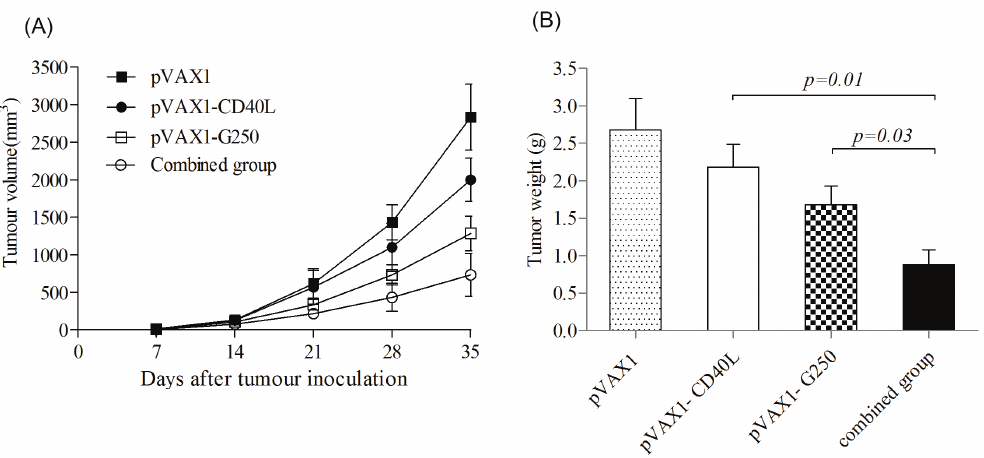
FIGURE 4 - Tumor-suppressing effects of immunization with recombinant plasmid DNA in the mouse xenograft model. (A) Growth curve of G250 ® RENCA tumors. (B) Mean tumor weight. Data are presented as mean ± S.D. Mean tumor volumes of mice immunized with the combination treatment was significantly smaller than that in mice in the other treatment groups (pVAX1, pVAX1-CD40L, or